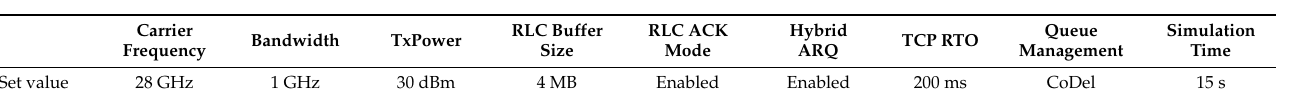
Figure 8. SINR changes in each scenario. Table 1. Simulation